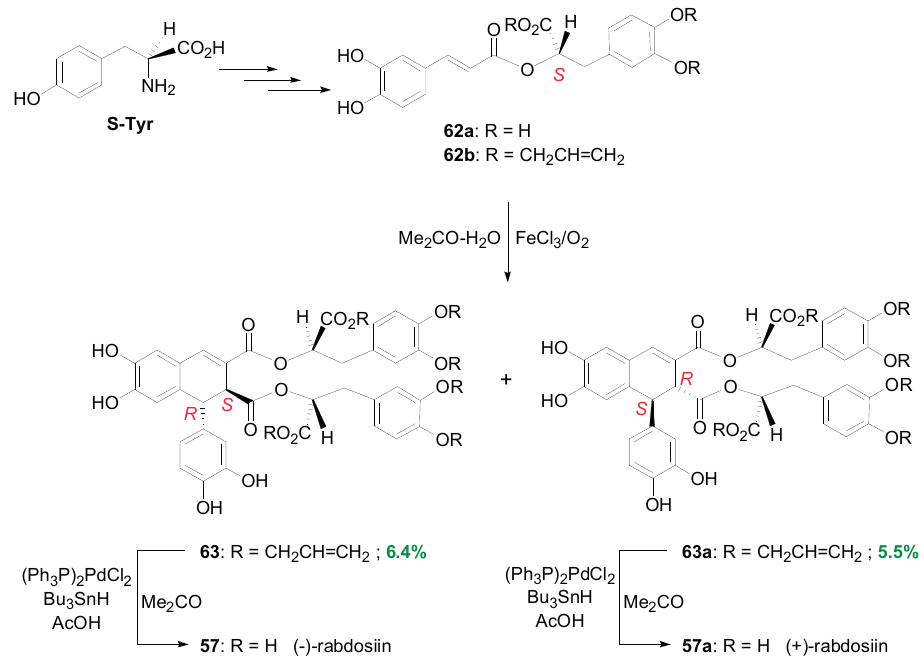
Scheme 33. POC of a triallylated derivative 62b of ( S )-( − )-RosA ( 62a ) en route to ( − )- and (+)-rabdosiin ( 57 and 57a ,